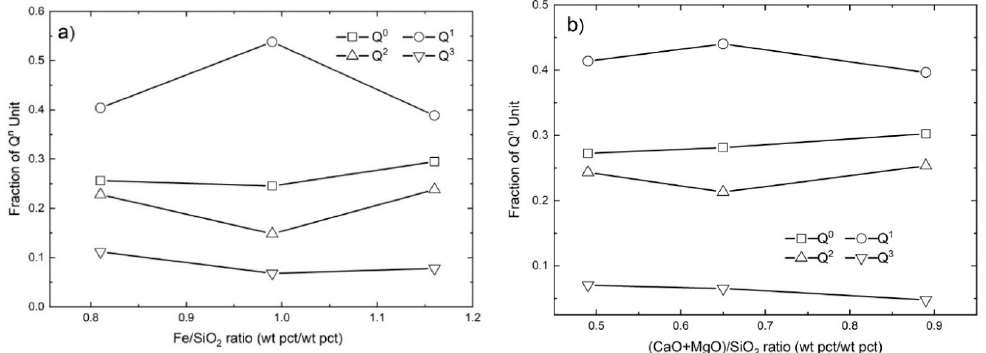
Figure 13. The relative abundance of structural units in FCSM-Cu 2 O-PdO slags equilibrated with Cu ( p O 2 = 10 − 8 atm and T = 1300 °C (1573 K)) as a function of: ( a ) Fe/SiO 2 ratio, and ( b ) basicity.